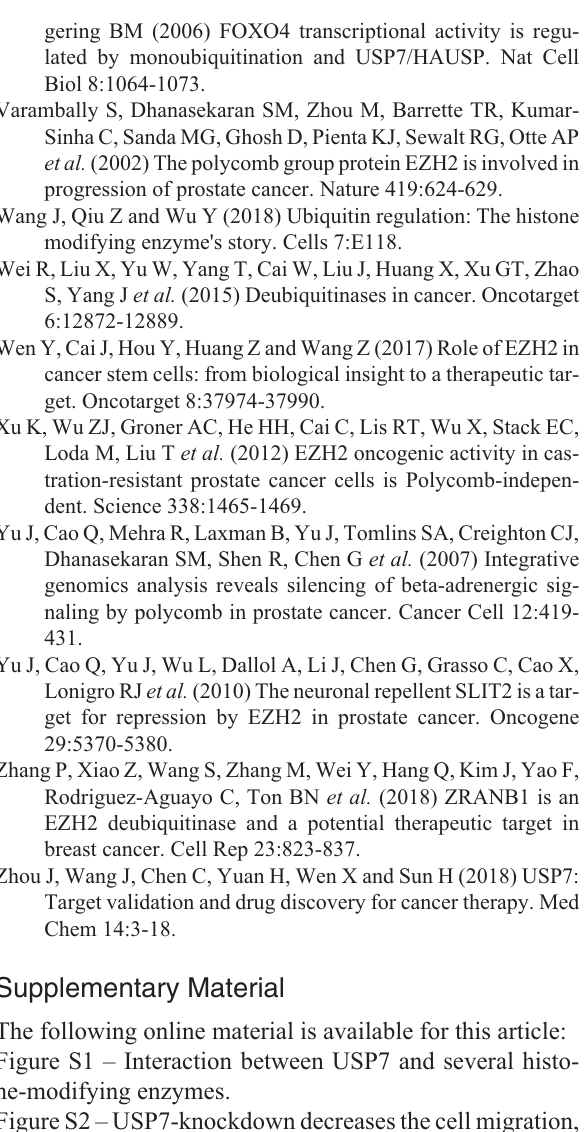
Figure S2 – USP7-knockdown decreases the cell migration, invasion, and sphere-forming abilities in DU145 and PC3 cells. Figure S3 – USP7 promotes the migration and invasion of PC3 cells via EZH2 stabilization. Figure S4 – Simultaneous treatment with P5091 and EZH2 inhibitor induces synergistic effects in PC3. Figure S5 – Sequencing chromatograms of USP7 construc- tions. Figure S6 – Sequencing chromatograms of EZH2